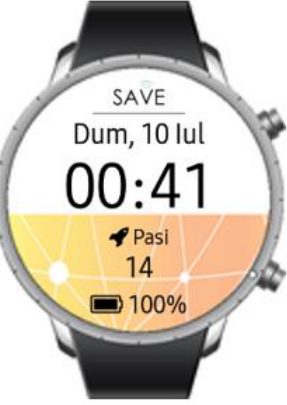
Figure 7. SAVE watch face.